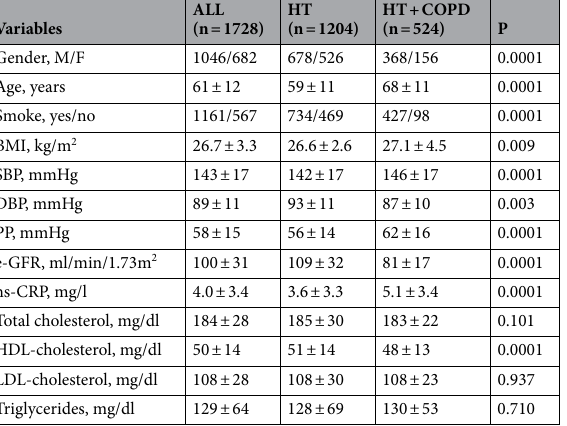
Table 1. Baseline demographic, hemodynamic, and biochemical characteristics of the whole study population and of the two groups separately. BMI: body mass index; DBP: diastolic blood pressure; e-GFR: estimated glomerular filtration rate; HDL: high density lipoprotein; hs-CRP: high sensitivity C reactive protein; LDL: low density lipoprotein; PP: pulse pressure; SBP: systolic blood pressure.